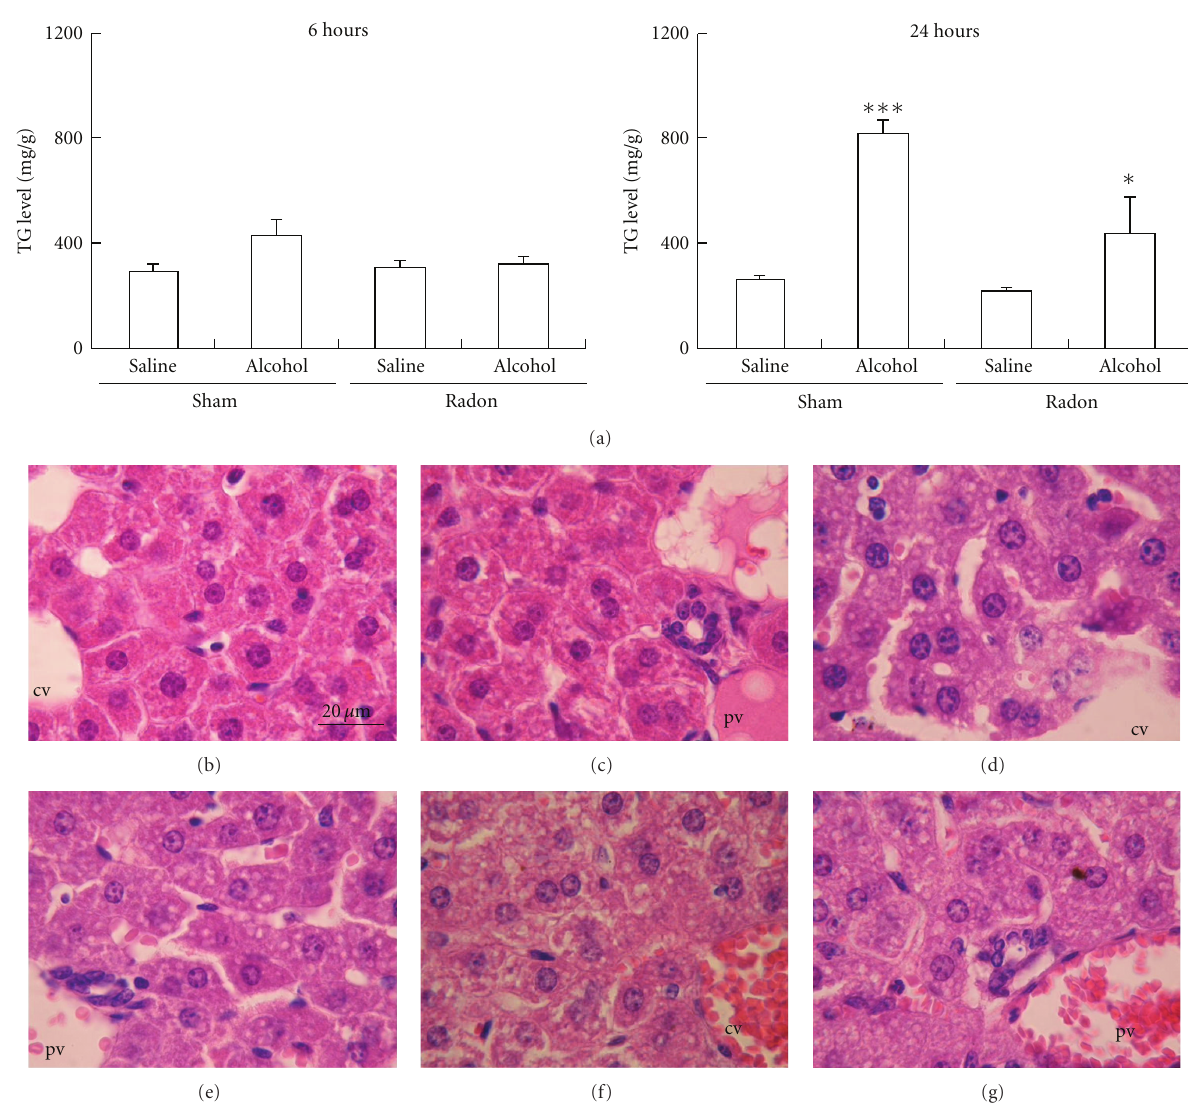
Figure 3: E ff ects of radon inhalation on TG level in liver (a) and histological changes in mouse liver after 24 hours following alcohol administration. (b), (c) sham inhalation before saline administration; (d), (e) sham inhalation before alcohol administration; (f), (g) radon inhalation before alcohol administration. The length of the scale bar is 20 μ m. All samples were stained with HE. The area of the vacuole formations surrounding the central vein (cv) and portal vein (pv). Each value indicates the mean ± SEM. The number of mice per experimental point is 4–6. ∗ P < 0 . 05, ∗∗∗ P < 0 . 001 versus each saline-administrated mice.